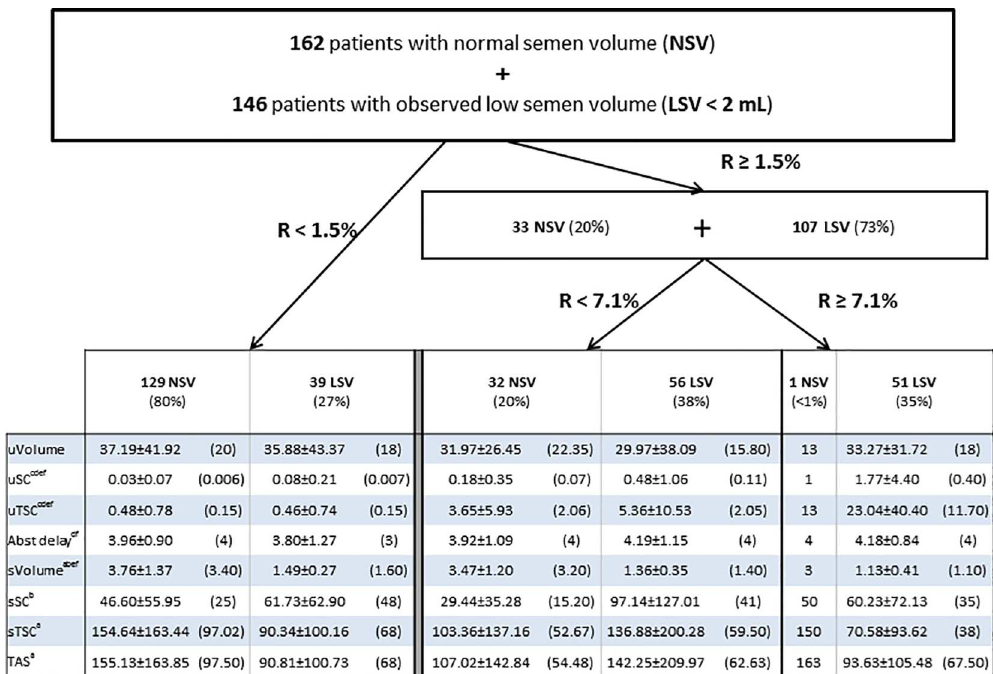
Fig 2. Semen and post ejaculatory urine characteristics as function of the R-value thresholds obtained from the CART procedure in 162 patients with normal semen volume (NSV) and 146 patients with observed low semen volume < 2 mL (LSV). Valuesare mean ± SD (median); 1.5% and 7.1%, thresholds values of R determined by the CART procedureon the 308 (162 plus 146) patients; % corresponds to numberof patients/total number of patients with NSV or LSV. Three rangesof R-valueclassifiedpatients: 80% of NSV patients (129/162) and 27% of LSV patients (39/146)were under an R-valueof 1.5%, 20% of NSV and 38% of LSV were comprised between1.5% and 7.1%, and less than 1% of NSV and 35% of LSV had an R-value (cid:21) 7.1%. R (%), [uTSC divided by (uTSC plus sTSC)] multiplied by 100 uVolume, urine volume (ml) uSC, urine sperm count (10 6 /ml) uTSC, urine total sperm count (uVolumemultipliedby uSC; 10 6 ) Abst Delay, abstinencedelay (days) sVolume, semen volume (ml) sSC, semen sperm count (10 6 /ml) sTSC, semen total sperm count (sVolume multiplied by sSC; 10 6 ) TAS, total amount of sperm (uTSC plus sTSC; 10 6 ) a p < 0.05 between129 NSV and 39 LSV b p < 0.05 between32 NSV and 56 LSV c p < 0.05 between 129 NSV (R < 1.5%) and 32 NSV (1.5 (cid:20) R < 7.1%) d p < 0.05 between39 LSV (R < 1.5%) and 56 LSV (1.5 (cid:20) R < 7.1%) e p < 0.05 between56 LSV (1.5 (cid:20) R < 7.1%) and 51 LSV (R (cid:21) 7.1%) f p < 0.05 between39 LSV (R < 1.5%) and 51 LSV (R (cid:21)